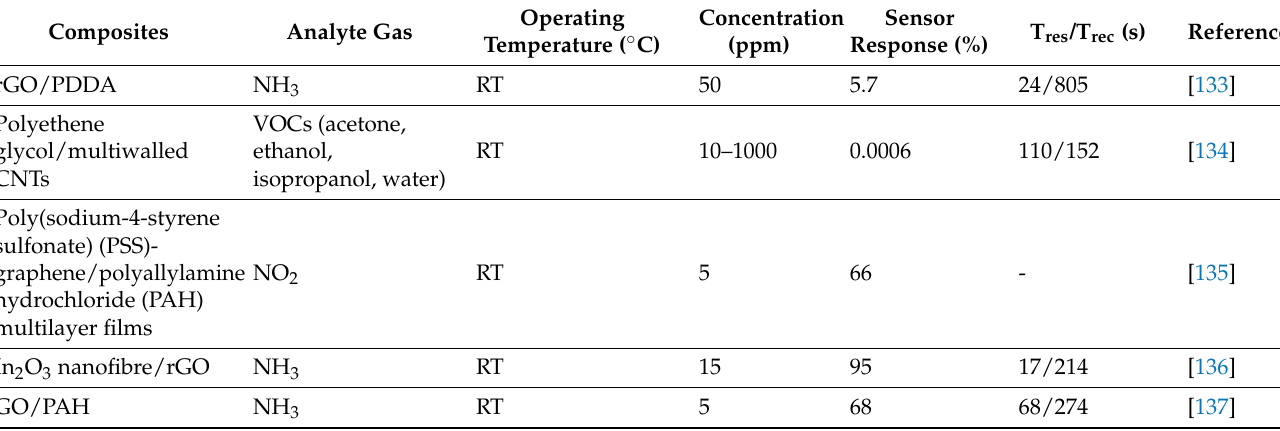
Table 6. Previous studies of graphene-based materials synthesised using the layer-by-layer deposition method.